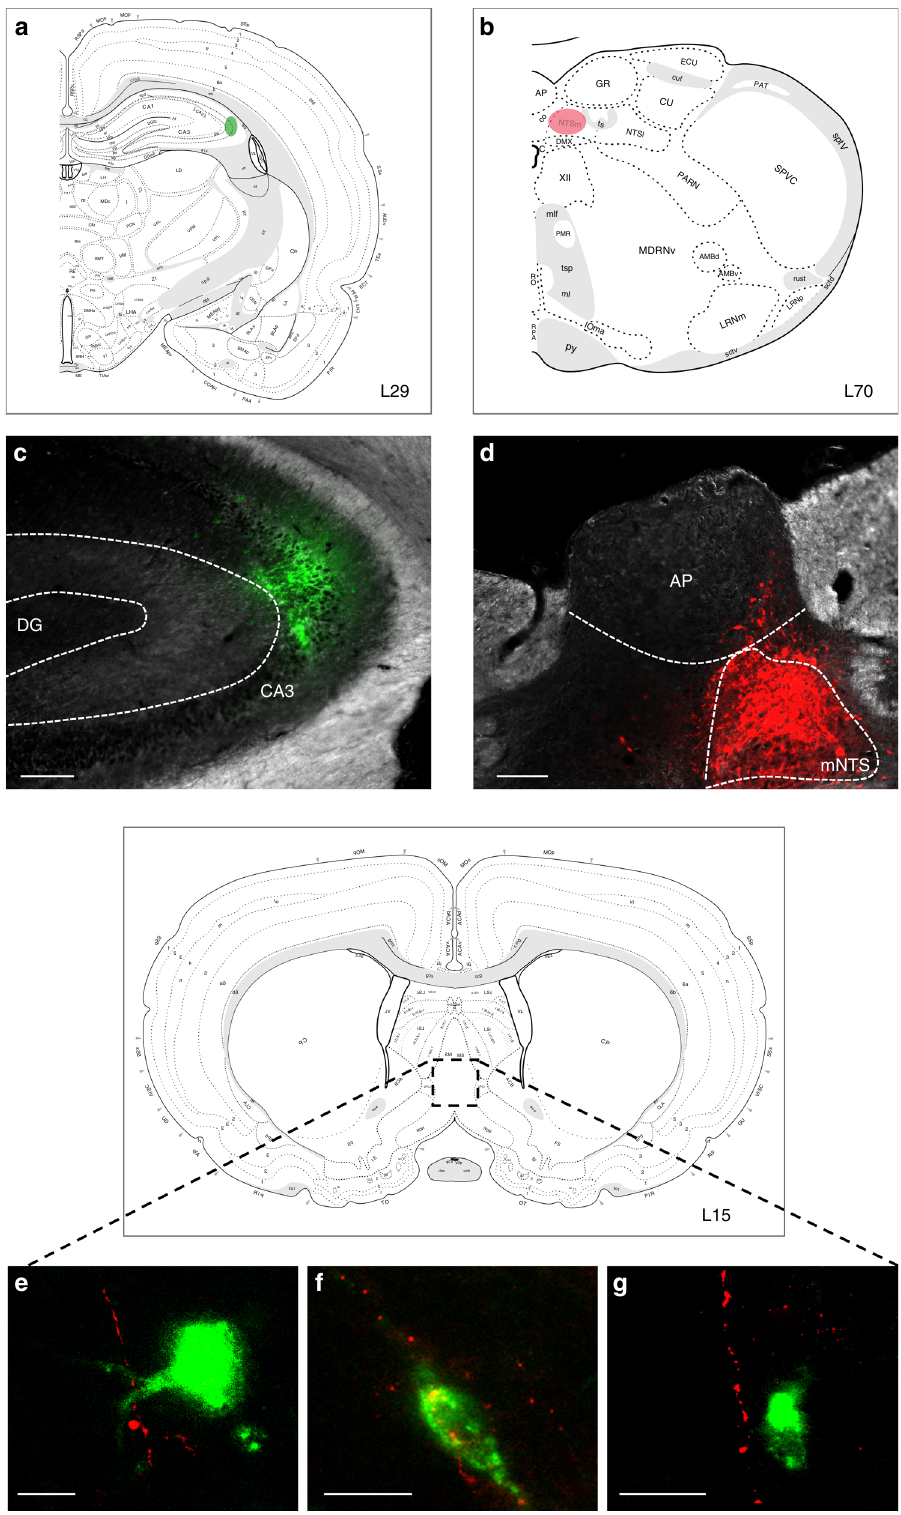
Fig. 6 Co-injection monosynaptic neural pathway tracing strategy identi fi es the medial septum (MS) as a relay region connecting the mNTS to the dHPC (CA3). Schematic representative injection sites in a dCA3 and b mNTS in Swanson Atlas level 29 and 69, respectively. c Unilateral iontophoretic dCA3 injection site of the retrograde tracer, CTB-488 (green). Scale bar: 100 μ m. d Ipsilateral and unilateral iontophoretic mNTS delivery of the anterograde viral tracer, AAV1-TurboRFP (red) ( n = 3 double hits, n = 11 controls). Scale bar: 500 μ m. e , f , g RFP-ir axons from the mNTS in apposition to CTB-488-ir cell bodies from dCA3 in the MS (images made by authors and adapted from Swanson Atlas level 15 68 ). Scale bar: 10 μ m. (AP area postrema, DG dentate gyrus, mNTS medial nucleus tractus